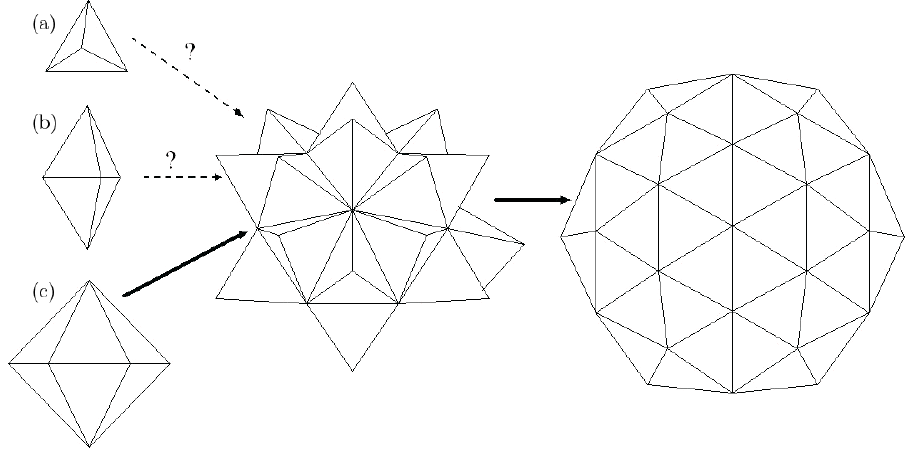
Fig. 3. Emergence of space from triangulated space